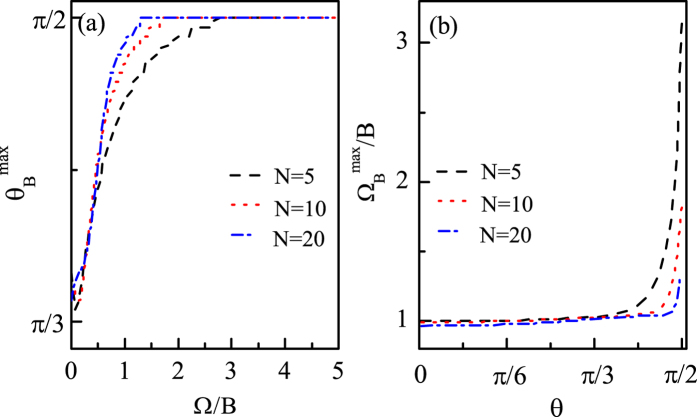
(a)  as a function of Ω for different N (b)  as a function of θ for different N. B = 1 and Γ0 = 0.03B.